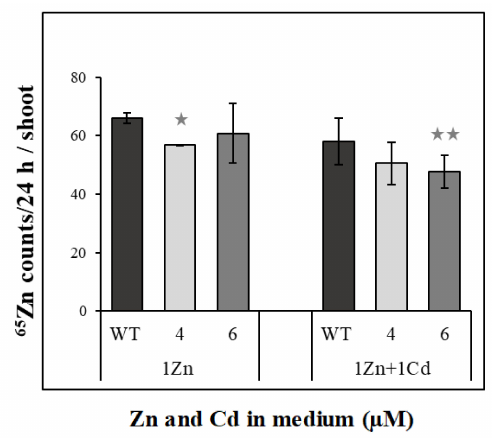
Figure 9. Total 65 Zn counts/24h in the shoots of wild-type and NtZIP4A / B -RNAi plants. 3.5-week- old plants of wild-type (WT) and NtZIP4A / B -RNAi lines (number 4 and number 6) grown in the quarter-strength Knop’s medium were exposed for six days to the control medium supplemented with 1 µ M Zn with or without 1 µ M Cd. For the seventh day (the last day of the experiment), seedlings were transferred to the Petri dishes filled with the medium of the same composition solidified with agar and covered with a thin layer of the liquid medium. The basal root part was immersed in the small vial filled with the medium of the same composition containing 65 Zn. Values correspond to means ± SD ( n = 3); those significantly different from wild-type (WT) (evaluated by Student’s t -test) are indicated by one asterisk ( p < 0.05) and two asterisks ( p <